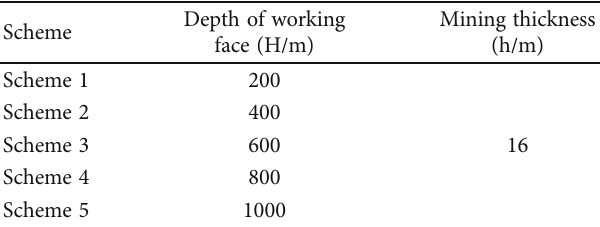
Table 2: Working face depth calculation scheme.